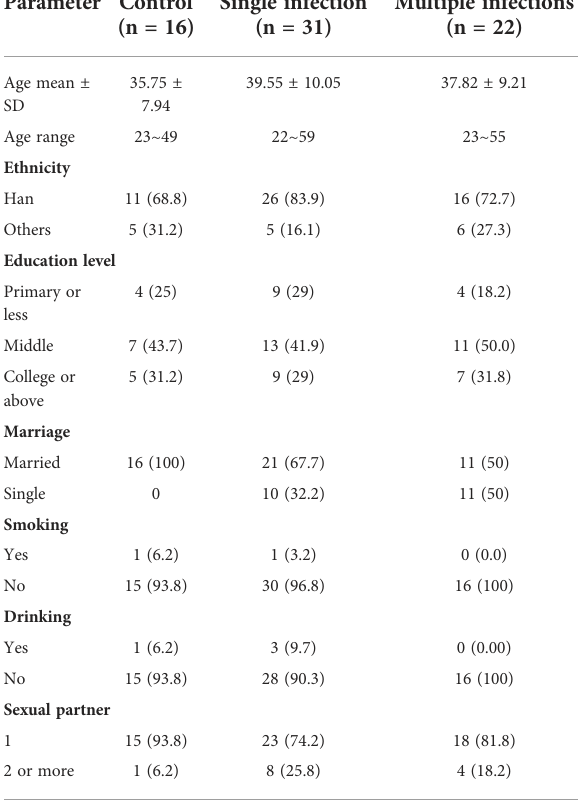
TABLE 2 Demographic characteristics of